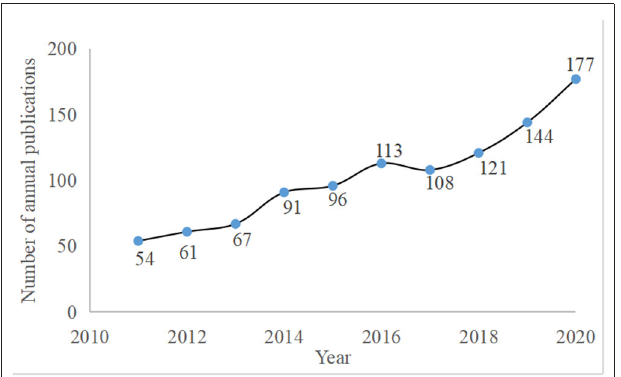
FIGURE 2 | Cited journal maps related to acupuncture treatment for depression research from 2011 to 2020.